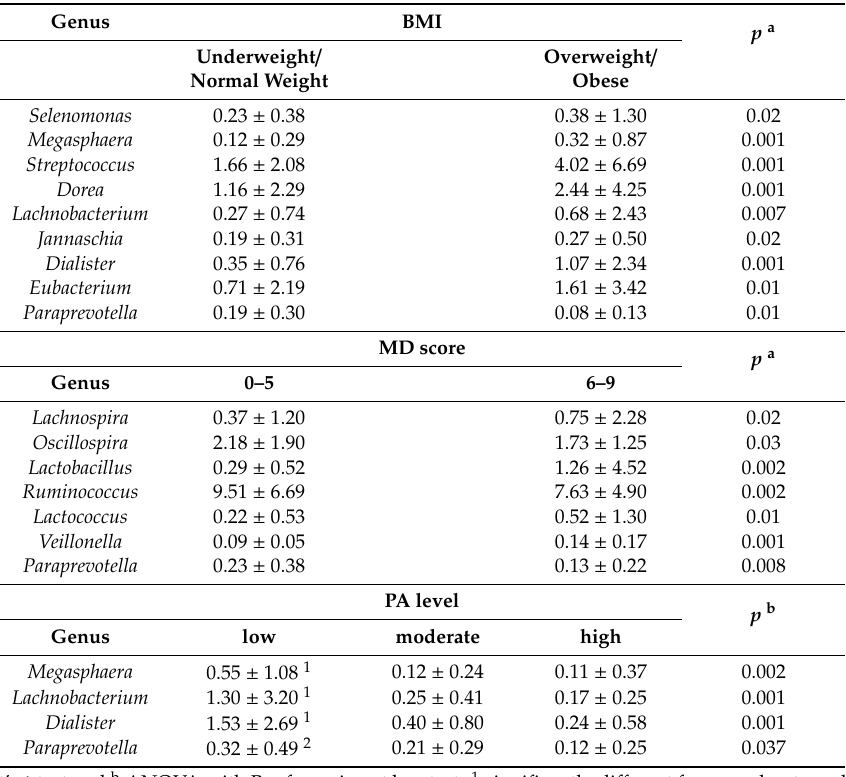
Figure 4. Heatmap and clustering of individual gut microbiota samples for taxonomic composition (genus level) in relation to the MD adherence. Clustering was based on Pearson distances and Ward’s linkage method. Only the genera above 2% abundance in at least one sample are depicted. Table 4. Relative abundance of significantly di ff erent genera in BMI, MD score, and PA